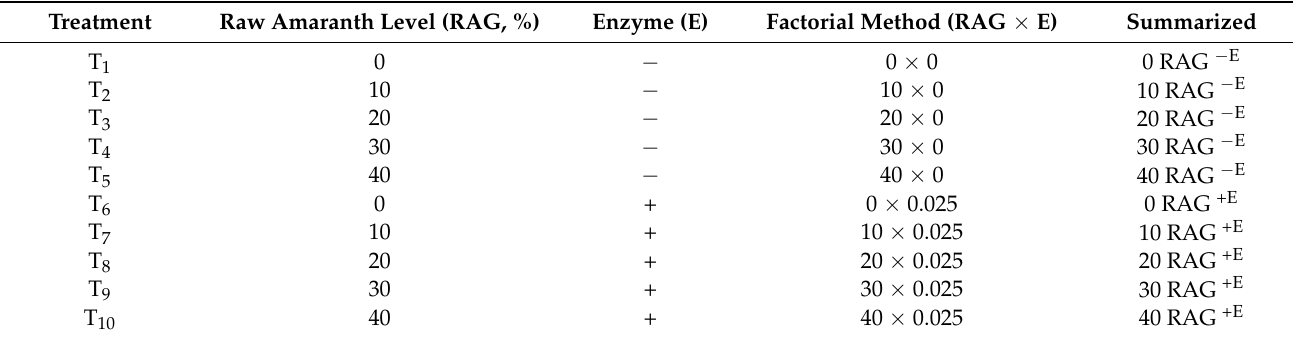
Table 1. Design of the experimental dietary treatments.